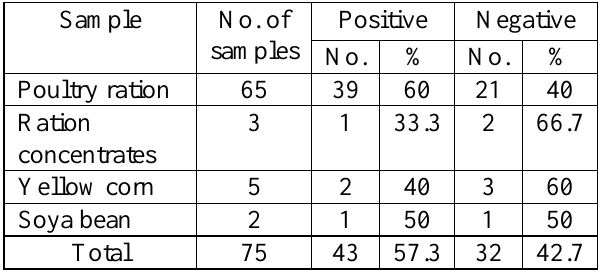
Table 6: Incidence of aflatoxin production in poultry